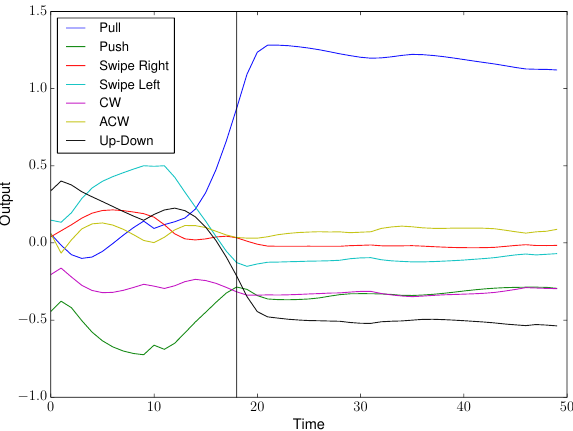
Figure 5. The figure shows the recognition of the pull (ID 1) input sequence from the initial presentation until the stabilisation of the network’s output. In the graph the output of the network is depicted, with each colour and line style representing a pattern recognised in the input. All values are plotted against